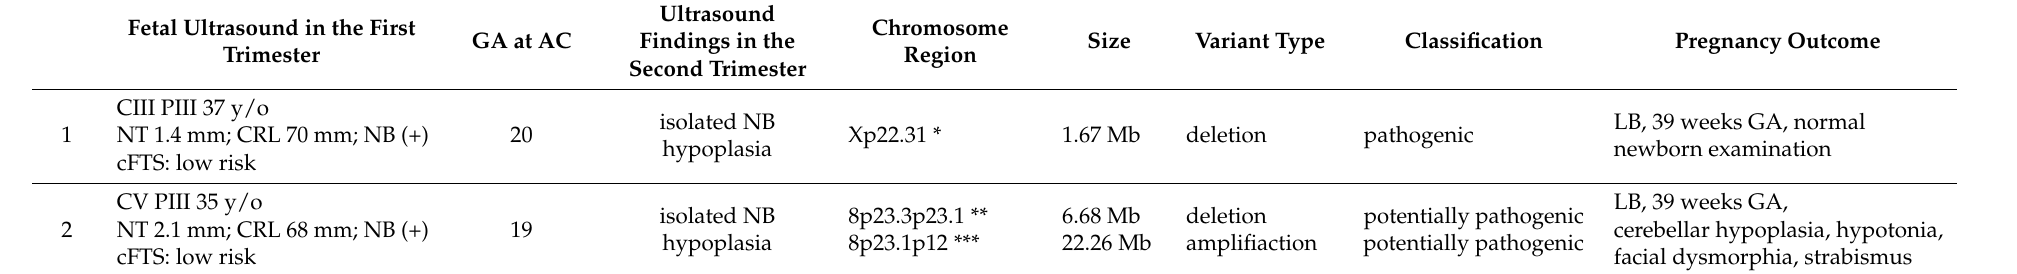
Table 1. Cases with isolated nasal bone hypoplasia and abnormal CMA results.